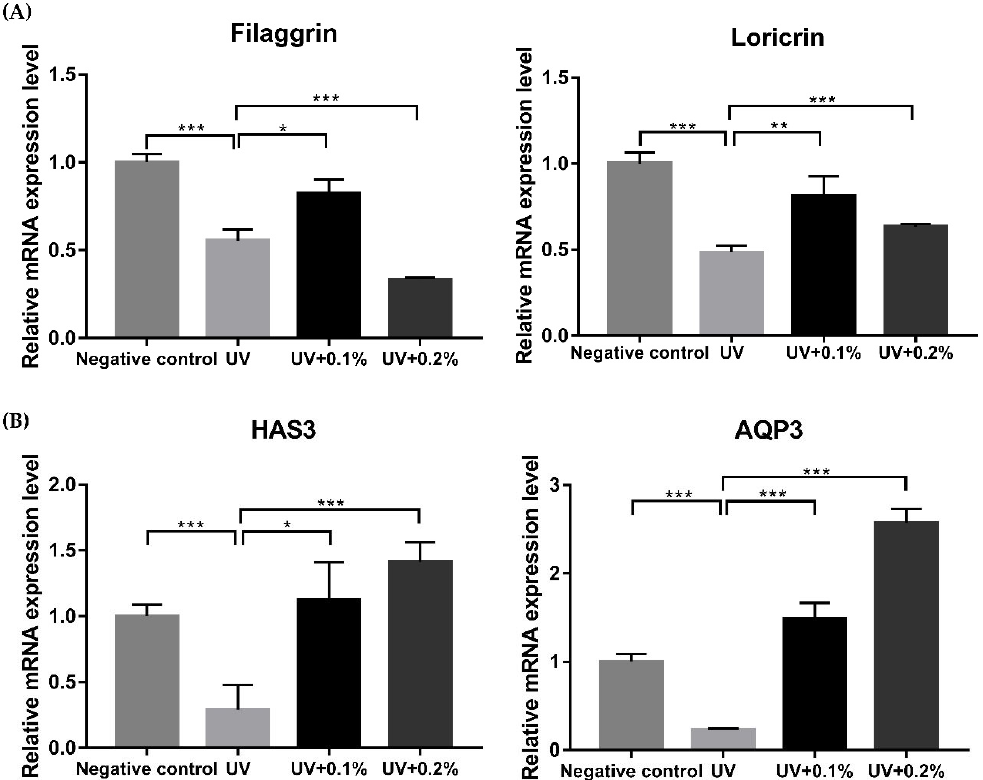
Figure 5. Expression levels of filaggrin , loricrin , HAS3, and AQP3 genes in untreated tissue specimen (negative control), and only UVB irradiated (UV), 0.1% (UV + 0.1%) and 0.2% (UV + 0.2%) H.ECM TM liposome treatment in UVB-irradiated tissue specimens. Expressions of genes encoding the factors related to the skin barrier function such as the filaggrin and loricrin were induced in the 0.1% and 0.2% H.ECM TM liposome treatment groups more than the UV group ( A ). The expression levels of genes COL1A1 and MMP1 encoding skin hydration factors were higher in the 0.1% and 0.2% H.ECM TM liposome treatments than the UV group ( B ). * p < 0.05, ** p < 0.01, *** p < 0.005.